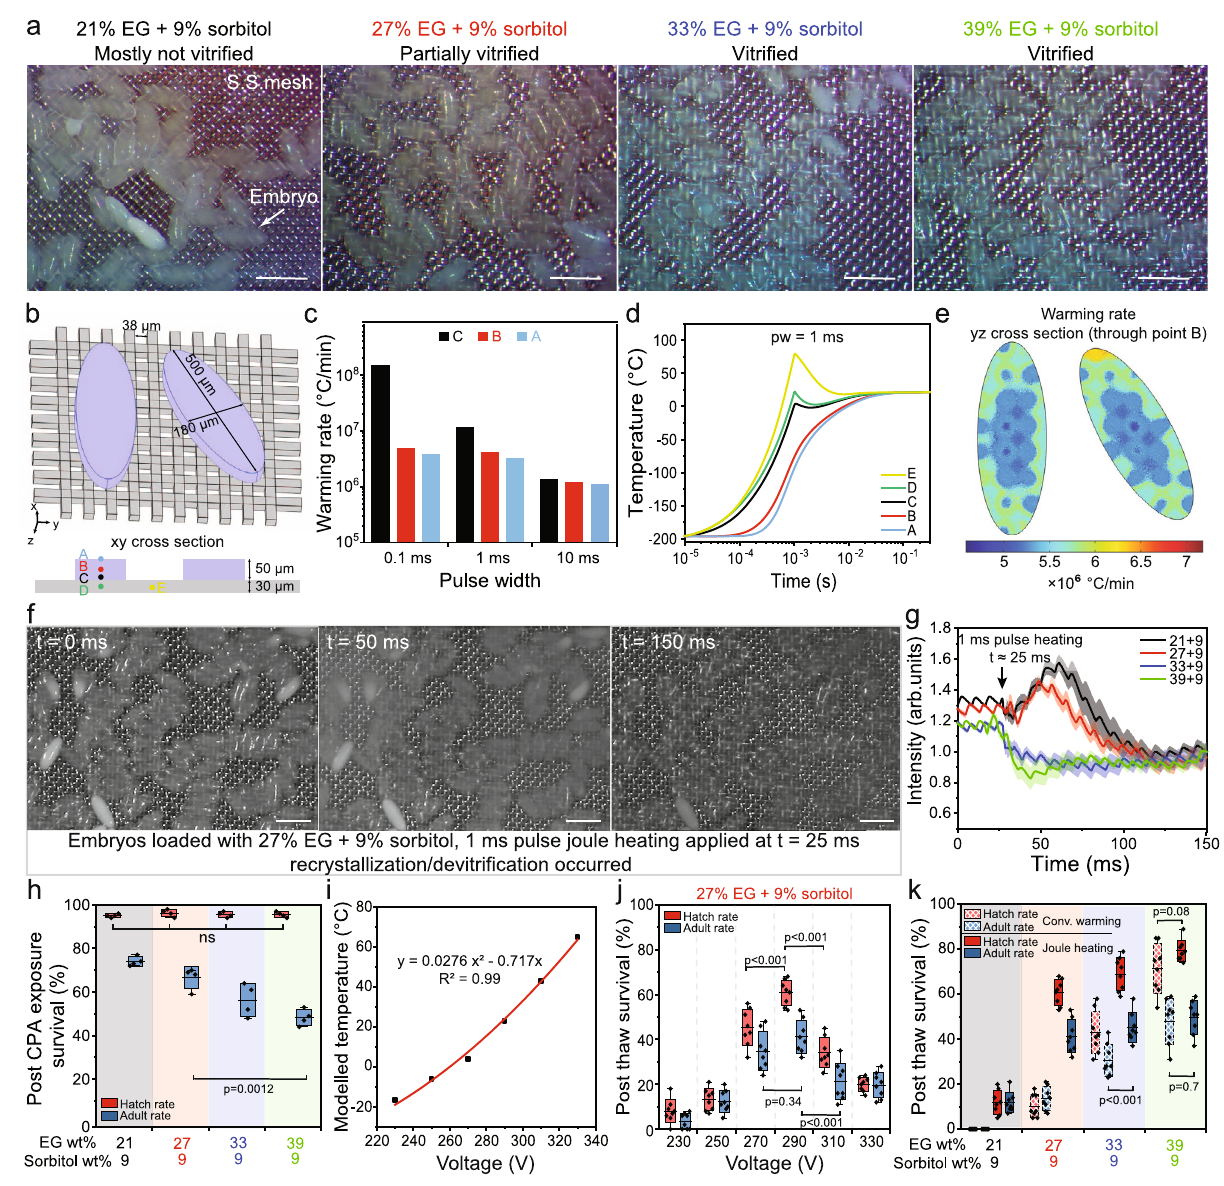
Fig. 4 | Drosophila embryos cryopreservation using joule heating. a Images of the Drosophila embryos on the stainless steel (SS) mesh after cooling. Embryos were loaded with different ethylene glycol (EG) concentrations. b Geometry and dimensionsoftheSSmeshandembryosusedintheheattransfermodeling.Points A,B,andCrepresentthetop,middleandbottomoftheembryo,respectively.Point DandErepresenttheSSmeshincontactwiththeembryoandoutsidetheembryo, respectively. c Temperature pro fi le at different locations for 1ms joule heating. d Warmingratedistributionatthe middle planeof embryos. e Warmingrate ofthe embryo for different joule heating pulse widths. f Images of embryos on the SS meshacquiredbyahigh-speedcameraat3000fps.Thecryoprotectiveagent(CPA) was 27% EG+9% sorbitol. The voltage was 290V. g Normalized grayscale intensity of the embryos was plotted from the high-speed camera videos. Ice (i.e., white color) showed a high intensity value. Different CPA concentrations (labelled as